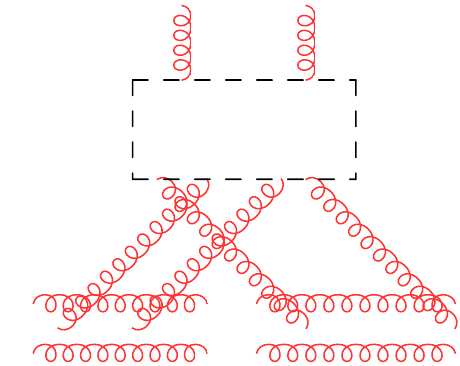
Fig. 2 QCD cut diagram representing nonlinear terms in (4) with 4 → 2 gluon recombination kernel (dashed box). The dashed box includes all possible pQCD diagrams which couple 4 gluons to 2